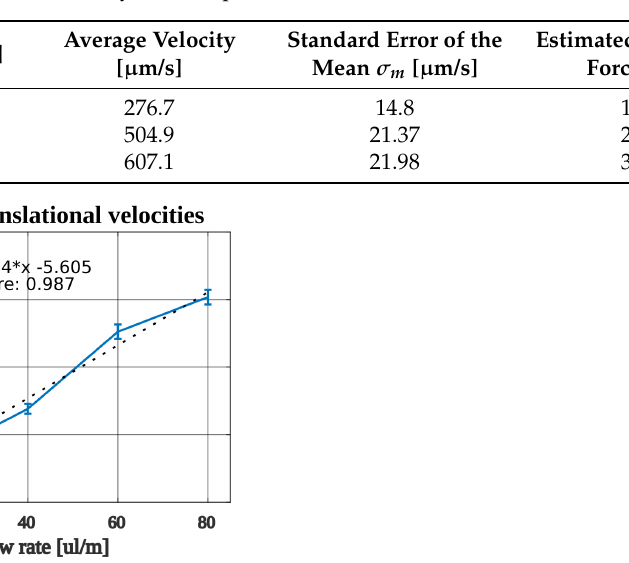
Table 4. Experimental results of crystal transport.